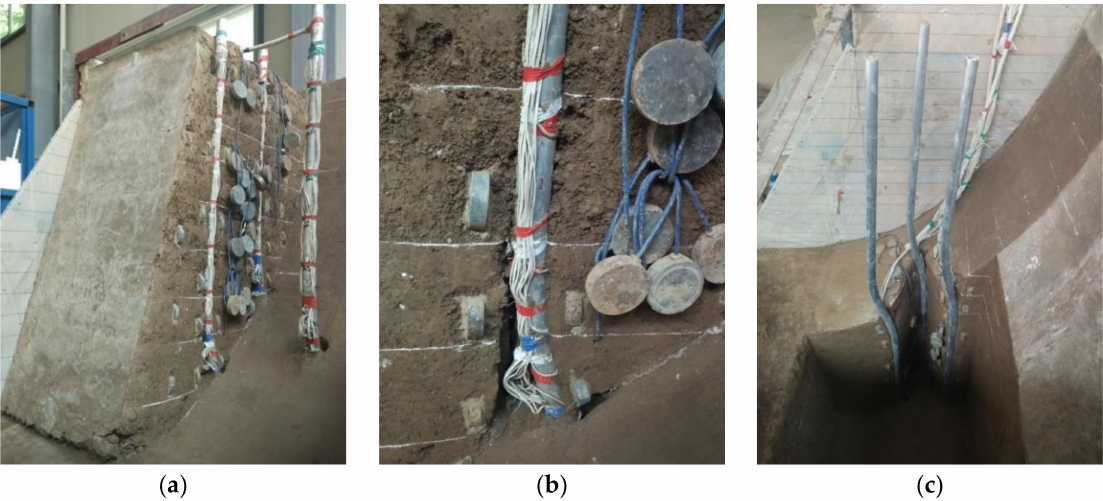
Figure 9. Damage of micro-piles: ( a ) overall damage of the model; ( b ) breakage of the pile near the slipping surface; ( c ) overall damage of micro-pile groups.